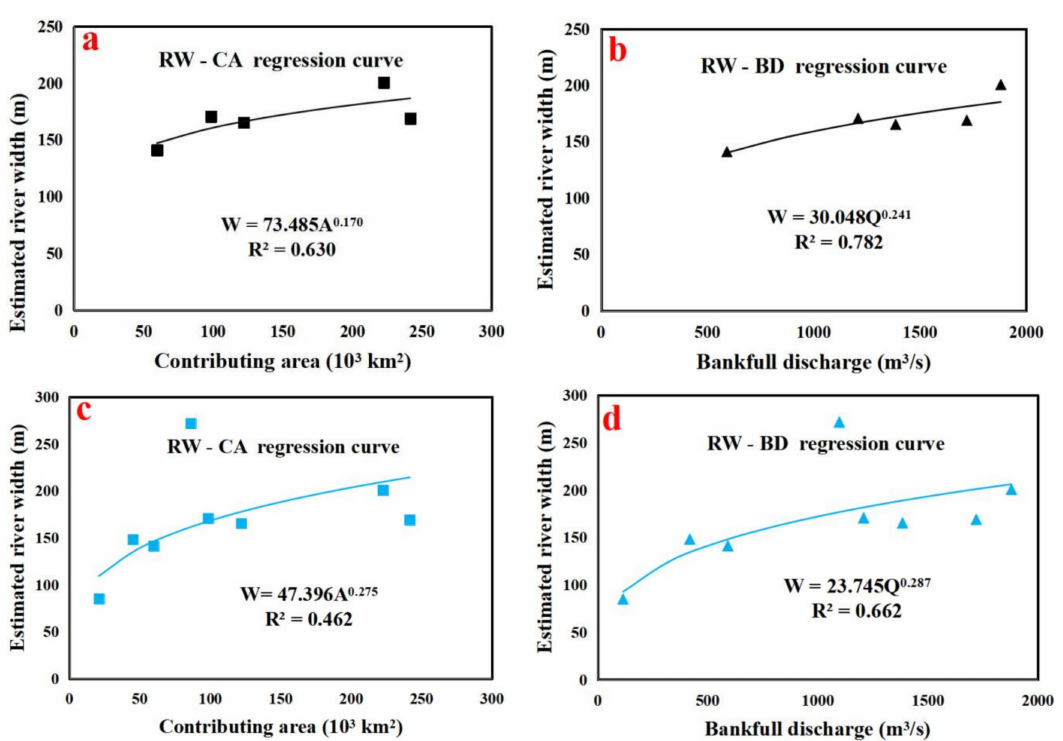
Figure 10. Regression relationships between the estimated river widths and the contributing areas and bankfull discharges. ( a , b ) The regressions of single-thread river reaches, excluding the hydrological stations affected by reservoirs; ( c , d ) the regressions of all river reaches, excluding the hydrological stations affected by